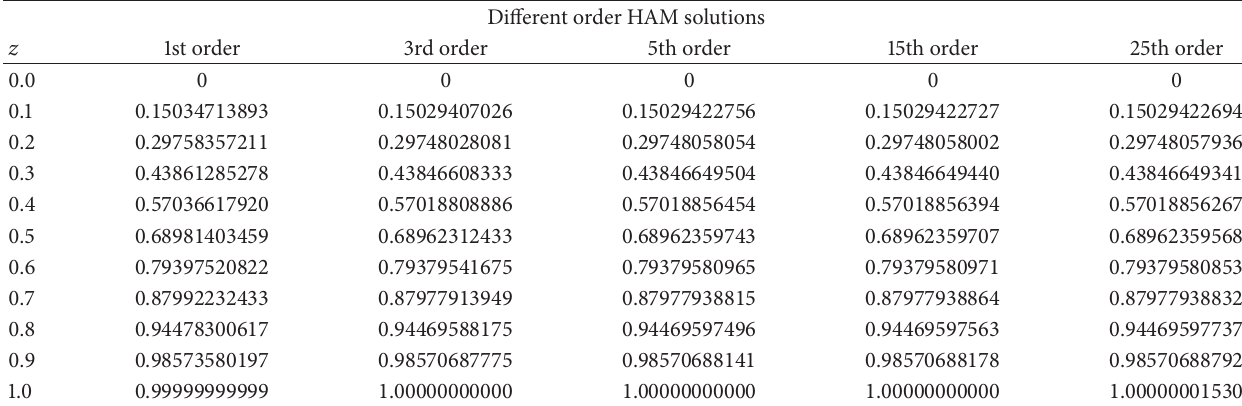
Table 5: Different order solutions keeping 𝑚 ℎ = 𝑚 𝑝 = 0.5 , 𝑅 𝑚𝑝 = 1 , and ℎ = −0.97 .